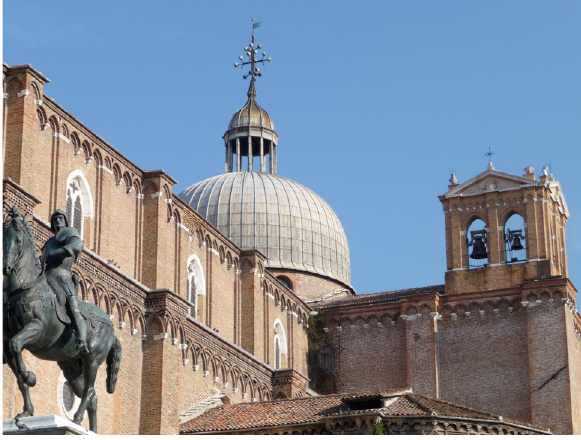
Figure 1. The dome of SS. Giovanni e